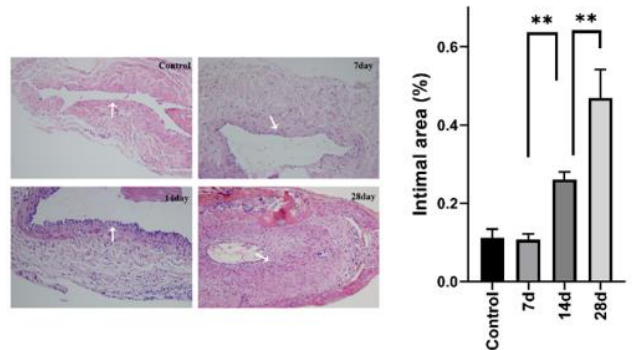
Figure 7. Histology results of the H&E-stained sections. Arrows indicate the thickened intimal of stenotic AVFs. Data analysis was performed using one-way ANOVA test. ** p < 0.01.